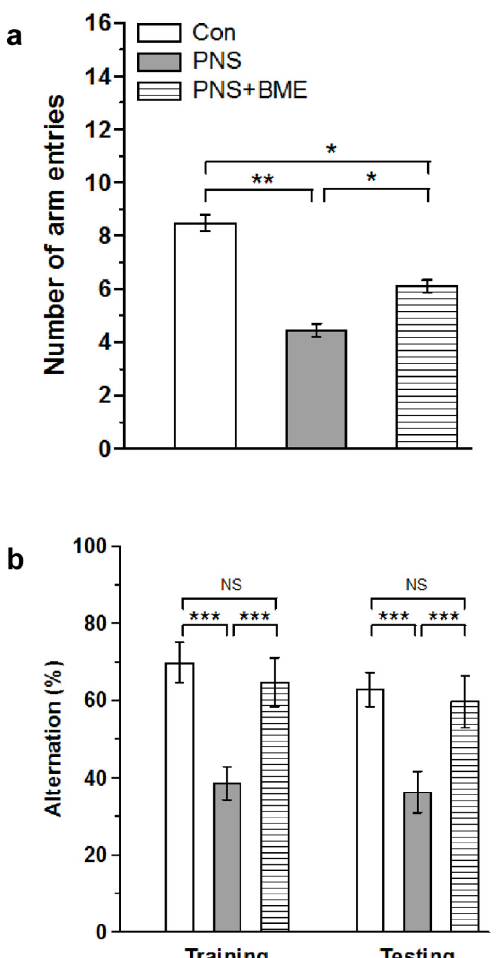
Figure 3. Exposure to BME treatment protects against PNS-induced memory impairment in offspring. The behavioral profile in the Y-maze. ( a ) The BME exposed group ( a ) made more arm entries than the PNS group ( b ) showed a higher percentage of alternations. Data are expressed as mean ± SEM (control n = 7, PNS n = 6, PNS + BME n = 6). One-way ANOVA followed by Bonferroni post hoc test (for all pairwise multiple comparisons, statistical significance is indicated by * p < 0.05, ** p < 0.01 and *** p < 0.001; NS—Not